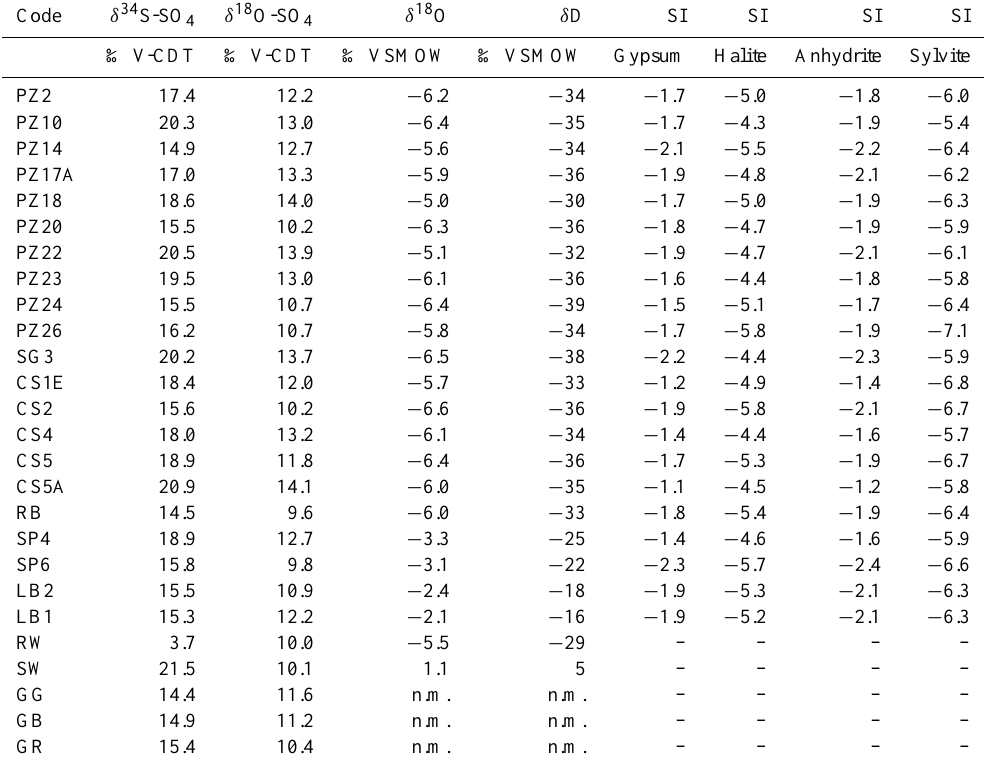
Table 2. Isotopic data and saturation indexes for a few mineralogical